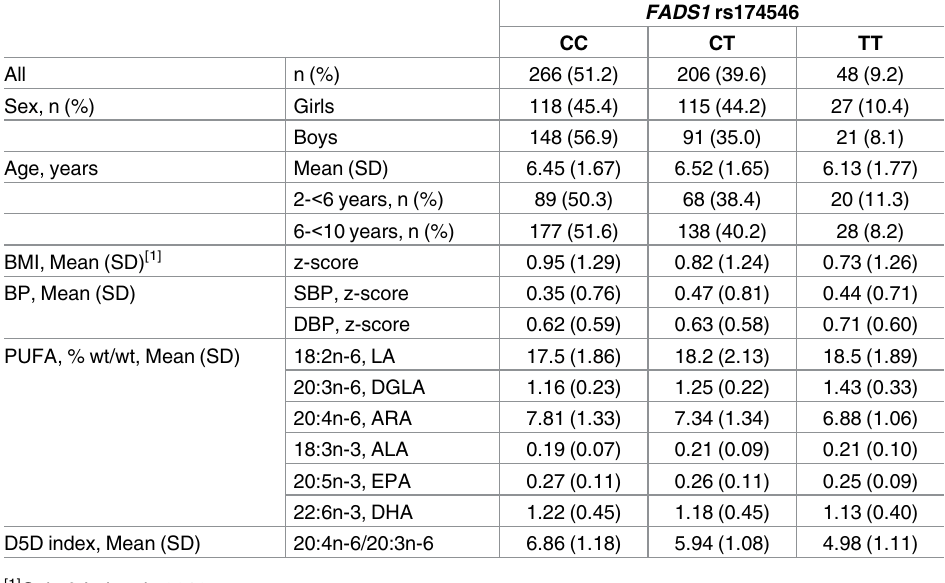
Table 2. Baseline characteristics of the study population by FADS1